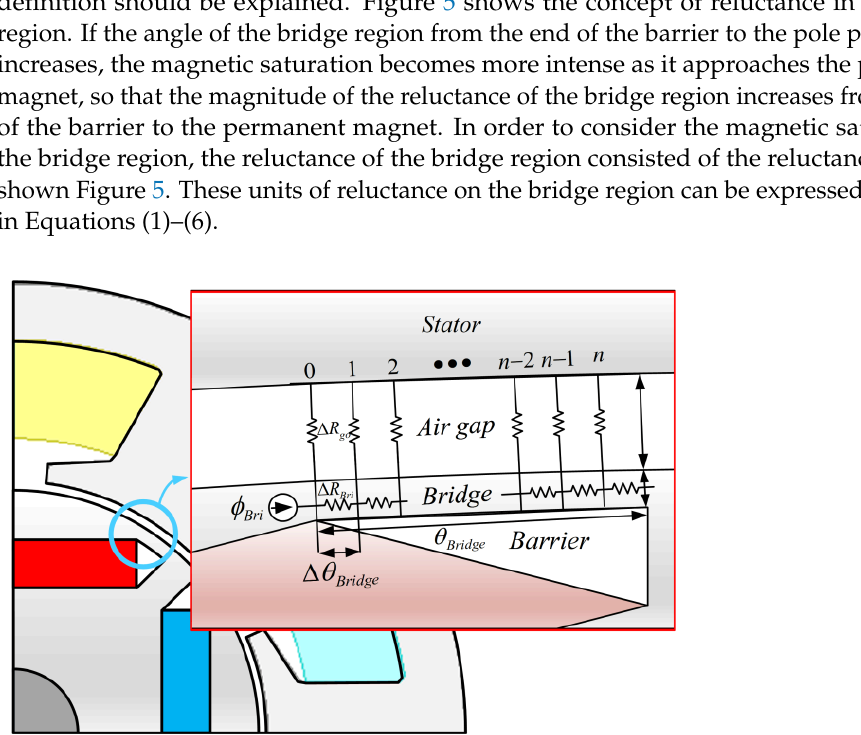
Figure 4. The magnetic circuit constructed for Equivalent Magnetic Circuit Method.